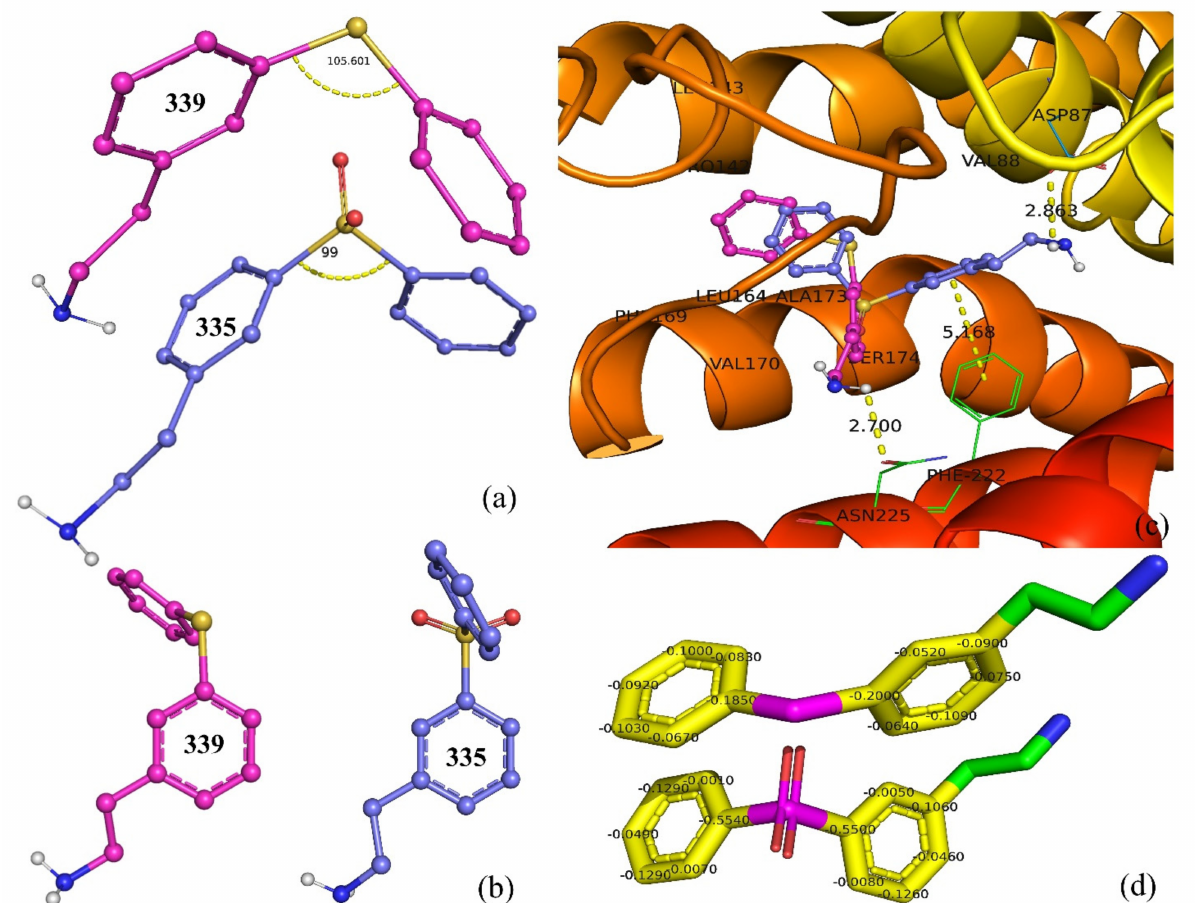
Figure 4. Molecules 335 and 339 as representative examples to depict the effect of descriptor ringC_S_4Bc. ( a ) Comparison of docking pose of 335 (pink) and 339 (blue), ( b ) C-S-C bond an- gle shown using yellow dotted lines, ( c ) docking pose for 335 (pink) and 339 (blue), ( d ) carbon atoms (yellow) within four bonds of sulfur (magenta) with respective partial